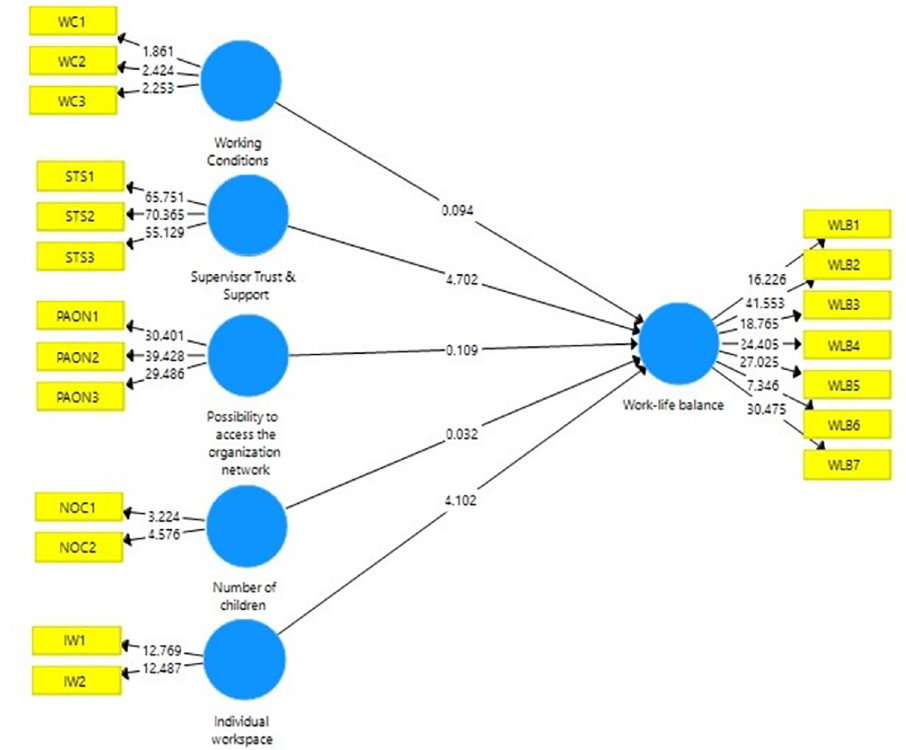
Fig 2. PLS results of the structural